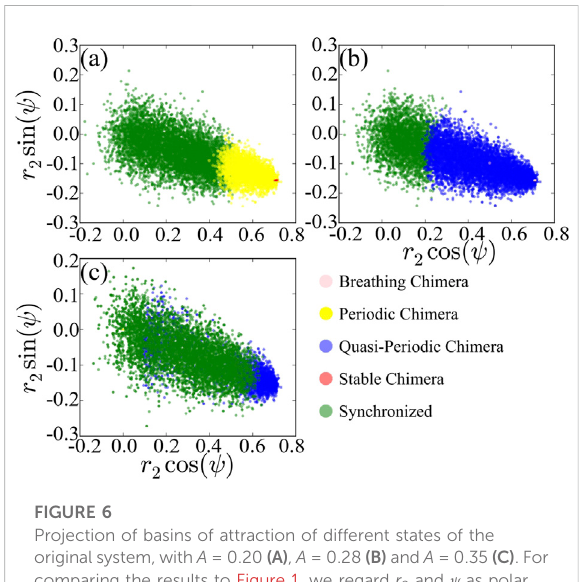
Projection of basins of attraction of different states of the original system, with A = 0.20 (A) , A = 0.28 (B) and A = 0.35 (C) . For comparing the results to Figure 1, we regard r 2 and ψ as polar